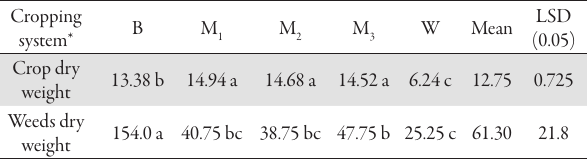
Tab. 6. Effect of different cropping system on performance of wheat